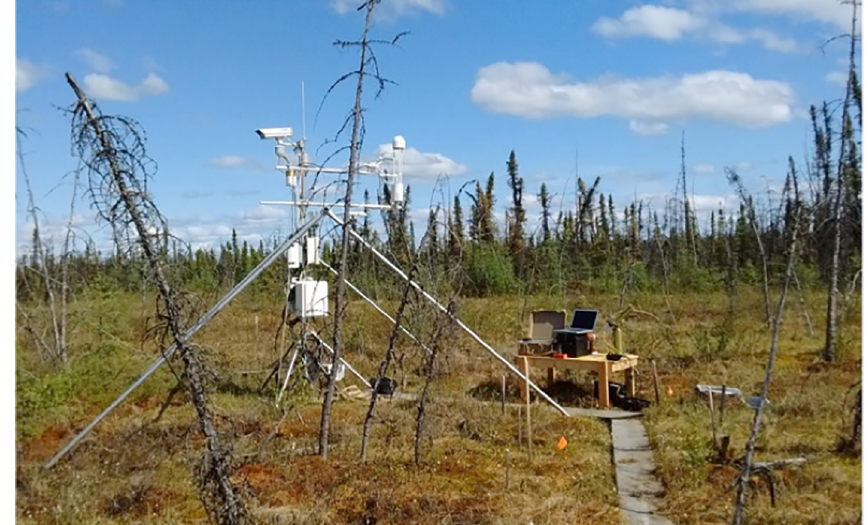
Figure 1. The mini-LHR (right) is portable and can be deployed to remote locations where larger TCCON installations are not possible due to the fragile ground conditions. Shown here are the mini-LHR monitors XCO 2 and XCH 4 alongside an eddy-covariance tower (left) in a collapse-scar bog permafrost site in Alaska. Table 1. Parameters used to calculate mini-LHR averaging kernels for the Bonanza Creek site. The molecules analysed in the